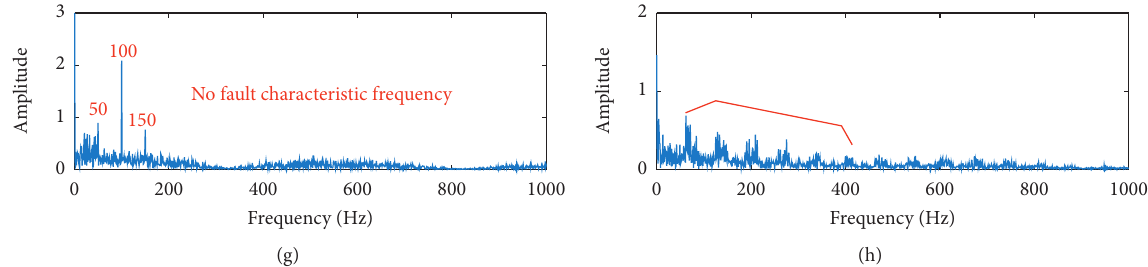
Figure 31: UC-DLA with parameters n � 20 , k � 26 ,L � 2 for identification of wheelset bearing roller fault. (a) Learned shock response 1; (b) learned shock response 2; (c) sparse reconstruction signal corresponding to shock response 1; (d) sparse reconstruction signal cor- responding to shock response 2; (e) locally zoomed figure of the impulses shown in Figure 31(c); (f) locally zoomed figure of the impulses shown in Figure 31(d); (g) envelope spectrum of signal in Figure 31(c); and (h) envelope spectrum of signal in Figure 31(d).